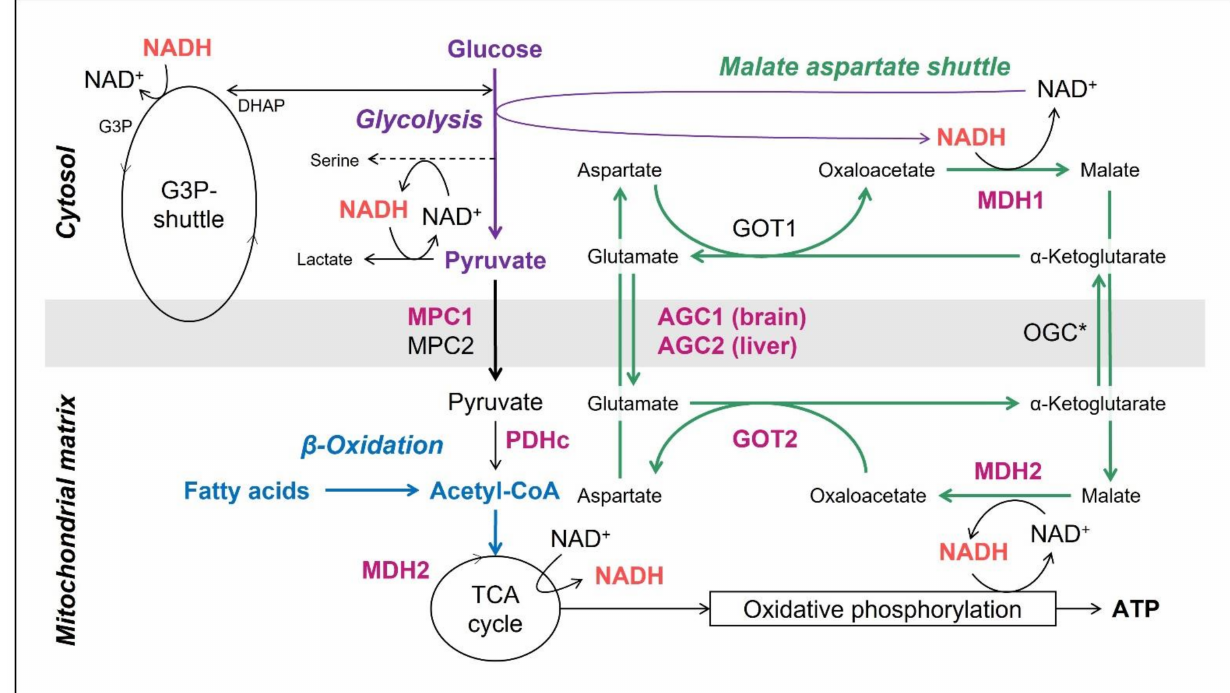
Figure 1. Malate aspartate shuttle (MAS) and the mitochondrial pyruvate carrier (MPC). The MAS is mainly responsible for the transfer of NADH across the inner mitochondrial membrane. MPC transport the end product of glycolysis—pyruvate—to the mitochondrial matrix, where it enters TCA cycle and finally oxidative phosphorylation. Fatty acids—from ketogenic diet —enter β -oxidation and thus bypass MAS and MPC. Proteins associated with human disease are written in bold pink. Glycolysis is inked in purple, MAS in green and β -oxidation (the bypass on KD) in blue. Of note, MDH2 takes part within the MAS and the TCA cycle. * Somatic variants in OGC have been re- lated to pheochromocytoma. Abbreviations: NAD = nicotine amid adenine dinucleotide (NAD+ oxidated form, NADH reduced form), AGC1 = aspartate glutamate carrier, AGC2 = citrin, OGC1 = oxaloglutarate carrier, MDH1/2 = malate dehydrogenase (cytosolic/mitochondrial isoenzymes), GOT1/2 = aspartate aminotransferase (cytosolic/mitochondrial isoenzymes), MPC1/2 = mitochon- drial pyruvate carrier 1/2 complex. G3P = glycerol-3-phosphate, DHAP = dihydroxyacetone phos- phate, TCA = tricarboxylic